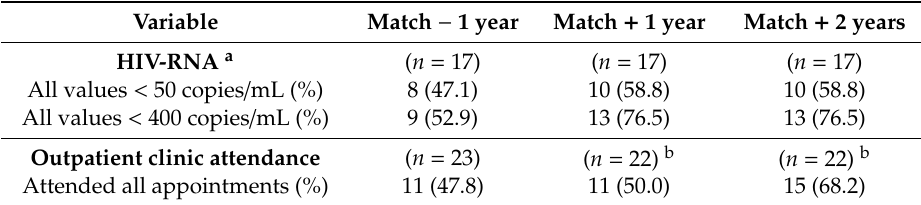
Table 3. HIV RNA and outpatient clinic